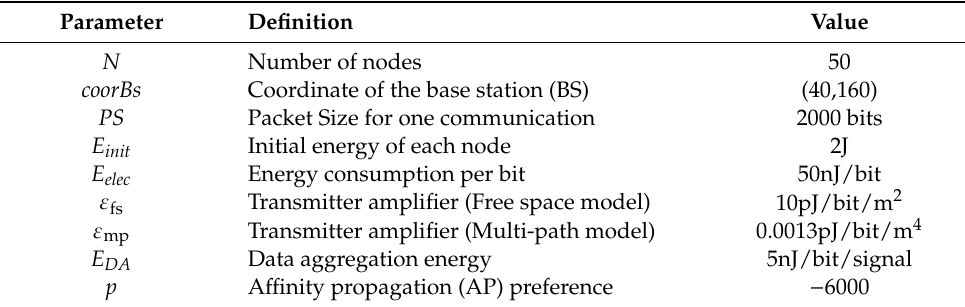
Table 2. Simulation